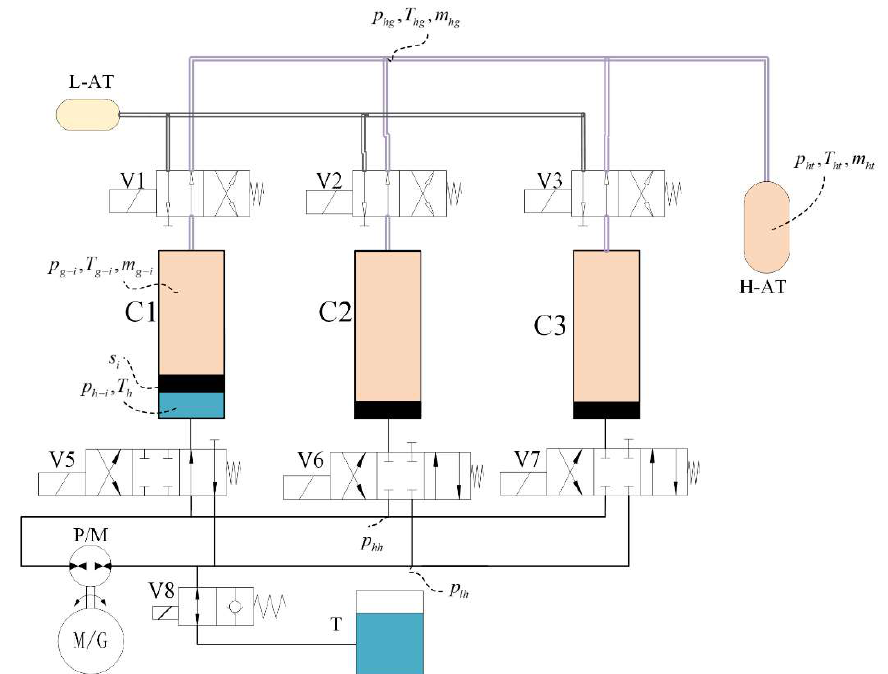
Figure 2. Structure of cycle hydro-pneumatic ESS.